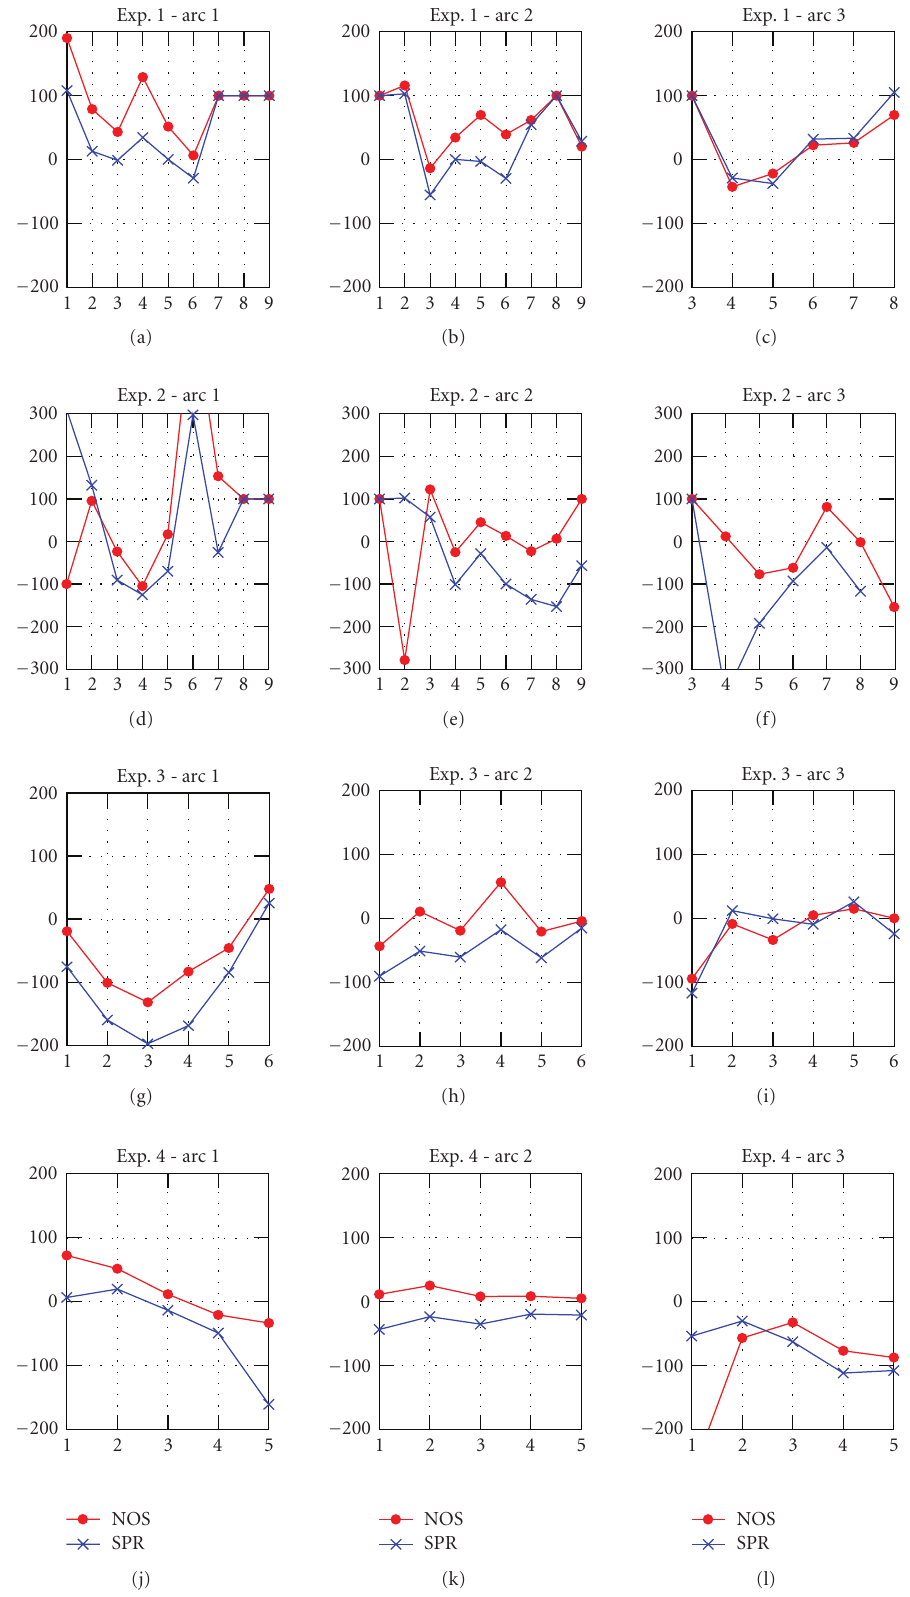
Figure 7: Normalized biases (expressed as a percentage) according to the experiment, of the arc of measurement points and time (NOS = Nostradamus code; SPR = MINERVE-SPRAY